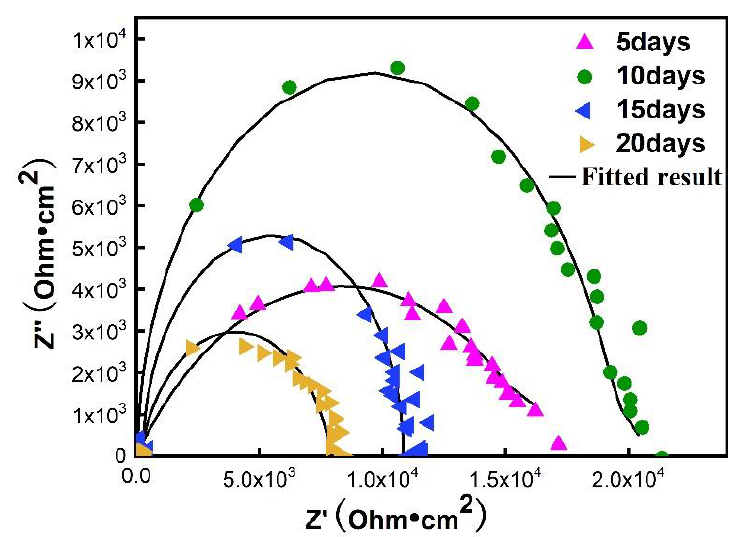
Figure 12. Nyquist plots of immersion samples in SBF.